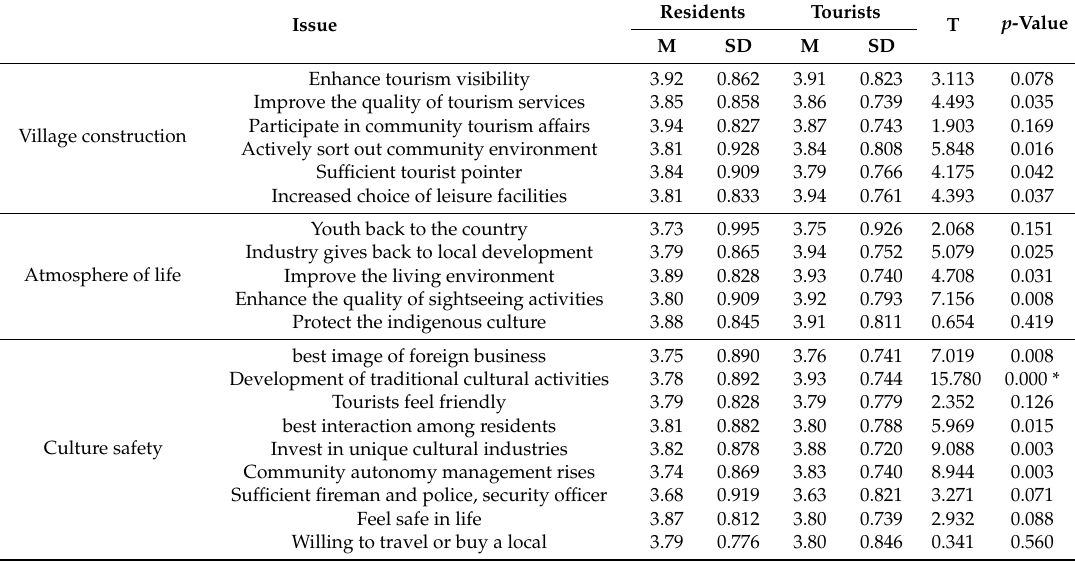
Table 8. Analysis of the di ff erences in perceptions of social development status among di ff erent stakeholders.